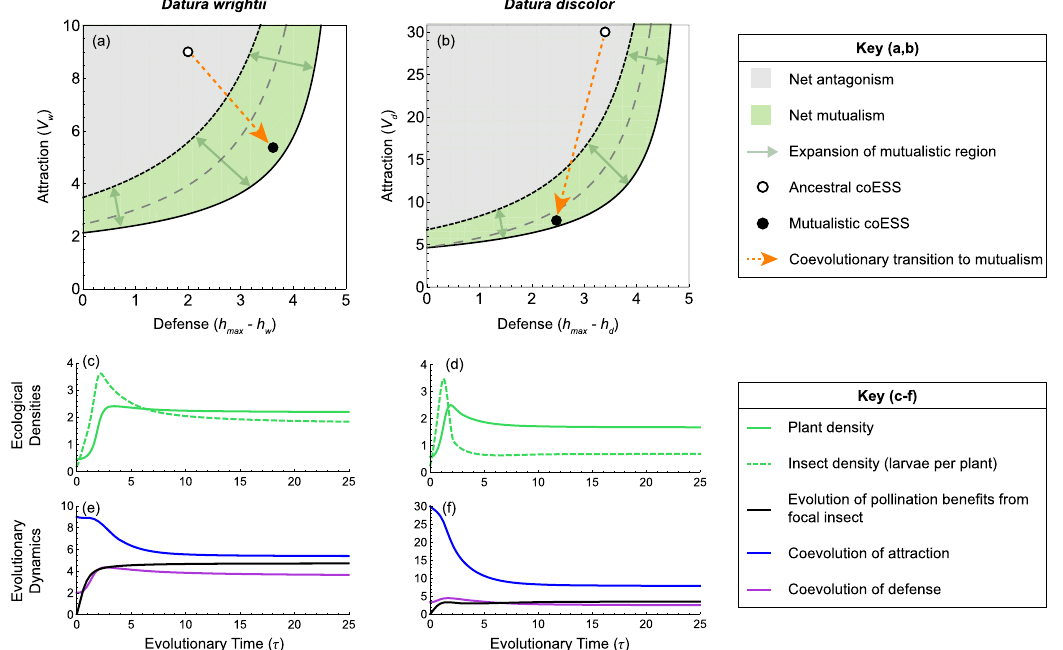
Fig. 2 Coevolution from antagonism to mutualism in one-plant species communities. Panels ( a , b ) show interaction outcomes as a function of attraction ( v i ) and defense ( h max − h i ), where h max is the maximum herbivory rate (Methods). Parameter space regions depict ecological outcomes and arrows highlight coevolutionary effects. The ancestral insect persists as a pure antagonist above the dashed gray line (Eq. 1) and is extinct below. Co-option of the antagonist as a pollinator and the evolution of pollination bene fi ts ( b i > 0) expands the green mutualistic region by moving the interaction breakdown boundary (Eq. 3; solid black line) away from the interaction transition boundary (Eq. 2; dotted black line), as depicted by the green arrows (see Supplementary Movies 1 and 2). The insect persists as a net antagonist despite being co-opted as a pollinator within the gray regions and goes extinct within the white regions. Simultaneous to the evolution of pollination bene fi ts, coevolution of attraction and defense drives the transition to net mutualism, as depicted by the orange arrows pointing from the ancestral coESSs (white points) to the new coESSs (black points). Empirical estimates of the coESSs are not included here (as in Fig. 3) due to data limitations. Panels ( c , d ) plot the equilibrium densities of each plant species (solid green lines) and insect larvae per plant of each Datura species (dashed green lines) over evolutionary time, τ . Panels ( e , f ) plot the coevolutionary dynamics of pollination bene fi ts ( b i ; black lines), attraction ( v i ; blue lines), and defense ( h i ; purple